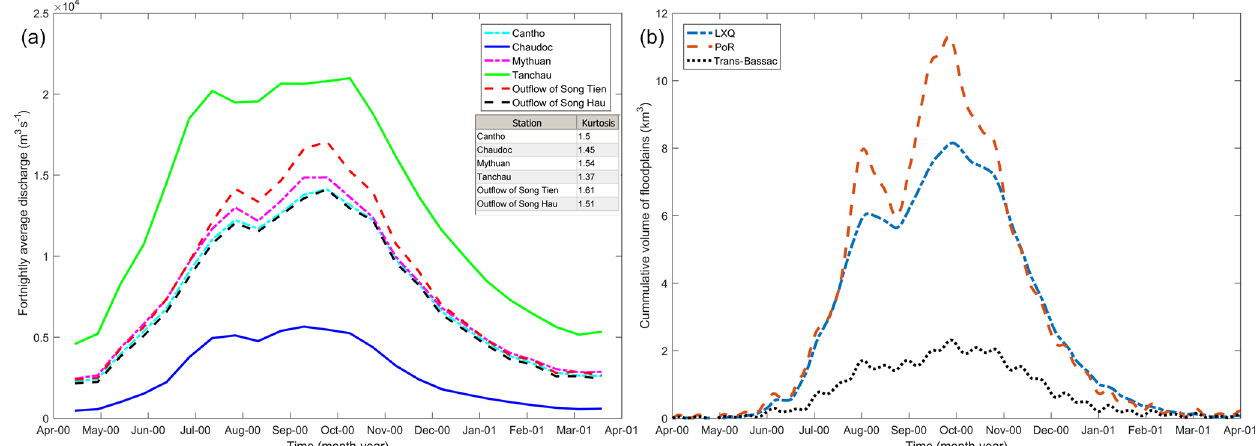
Figure 9. Fortnightly average discharges at stations along the Mekong branches (a) and cumulative water volumes of the major floodplains in the VMD (b)